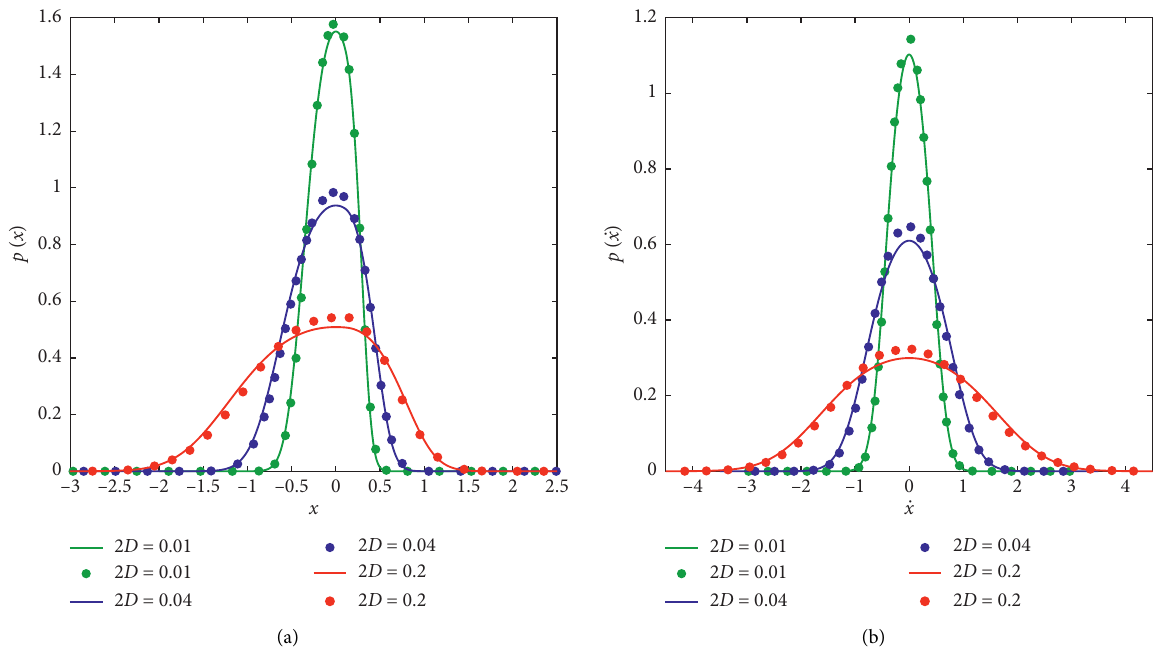
Figure 4: The PDF of the nonlinear system under different Gaussian white noise intensities 2 D . (a) The displacement PDF; (b) the velocity � 1, solid lines: the analytical results, and circles: MCS PDF ( k 1